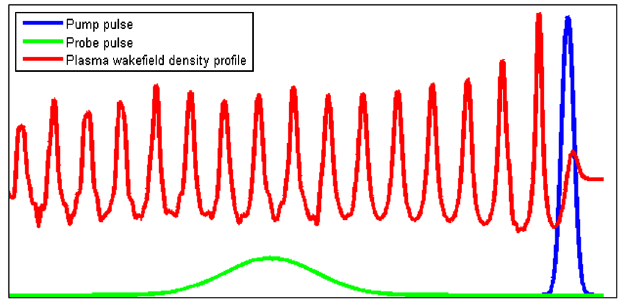
FIG. 1. Configuration of the simulation setup. The figure is not in